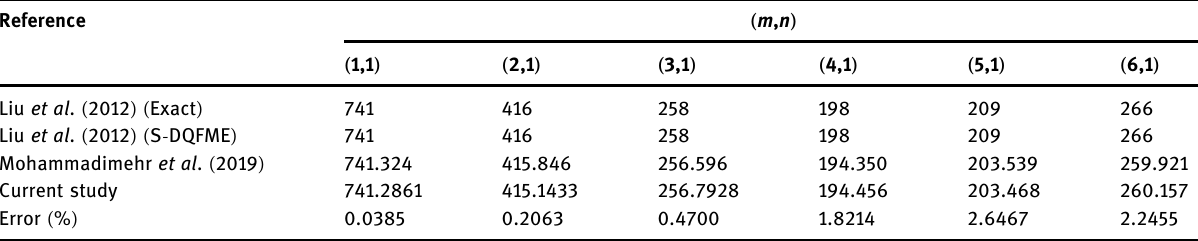
Table 1: Comparing the results for a simpler state with those of previously published works ( Hz )